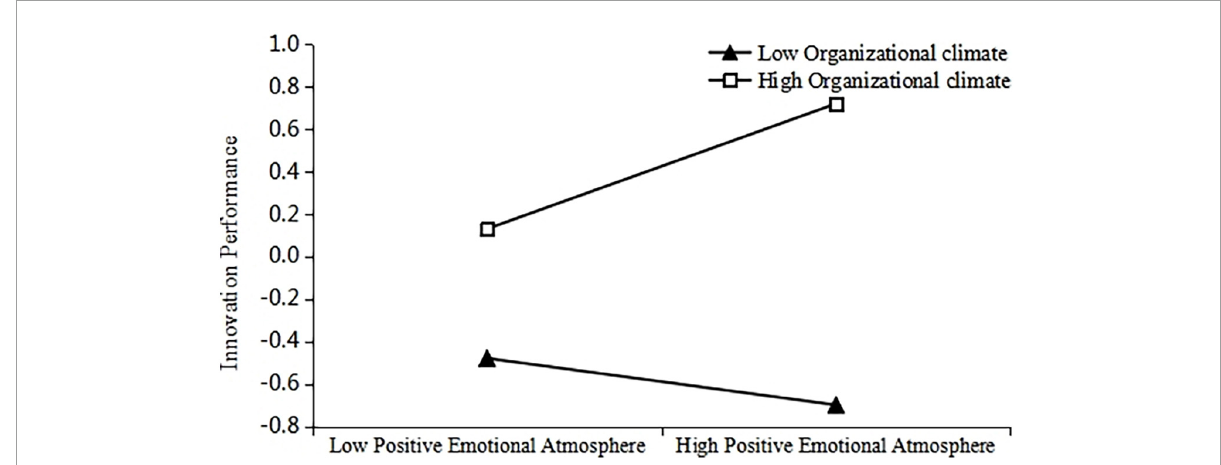
FIGURE2 The moderating role of organizational climate on the relationship between positive emotional atmosphere and innovation